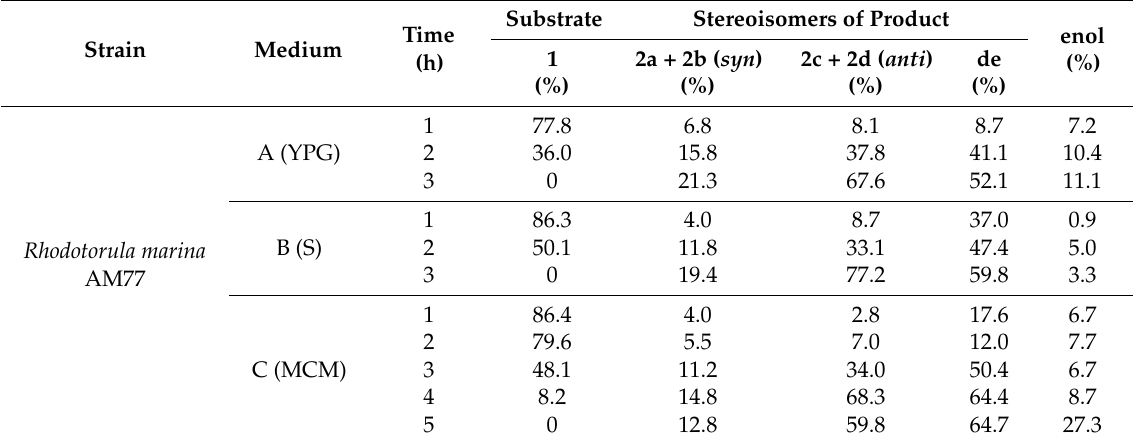
Table 2. The results of biotransformation of α -acetylbutyrolactone 1 by R. marina AM77 in different media (in % according to GC (chiral column)).